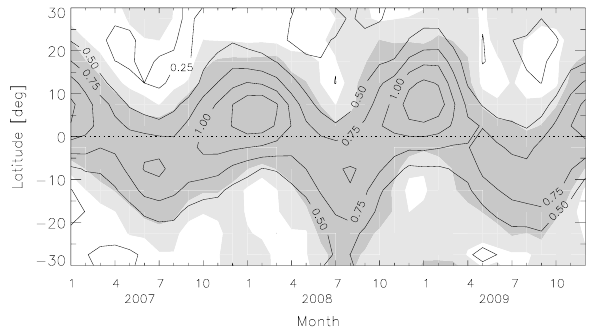
Fig. 2. Amplitudes of the diurnal temperature tide at 9hPa ( ∼ 32km) as a function of latitude (30 ◦ S–30 ◦ N) and month of COSMIC RO observations from 2007 to 2009. The contour inter- val is 0.25K. The two-gray-level shaded region denotes the regions where the signal-to-ratio (SNR) of the fitted amplitude over fitting errors are greater than 2 (light gray) and 3 (dark gray), as discussed in Sect. 2.3. Note that almost all amplitudes in the domain have SNR > 1.